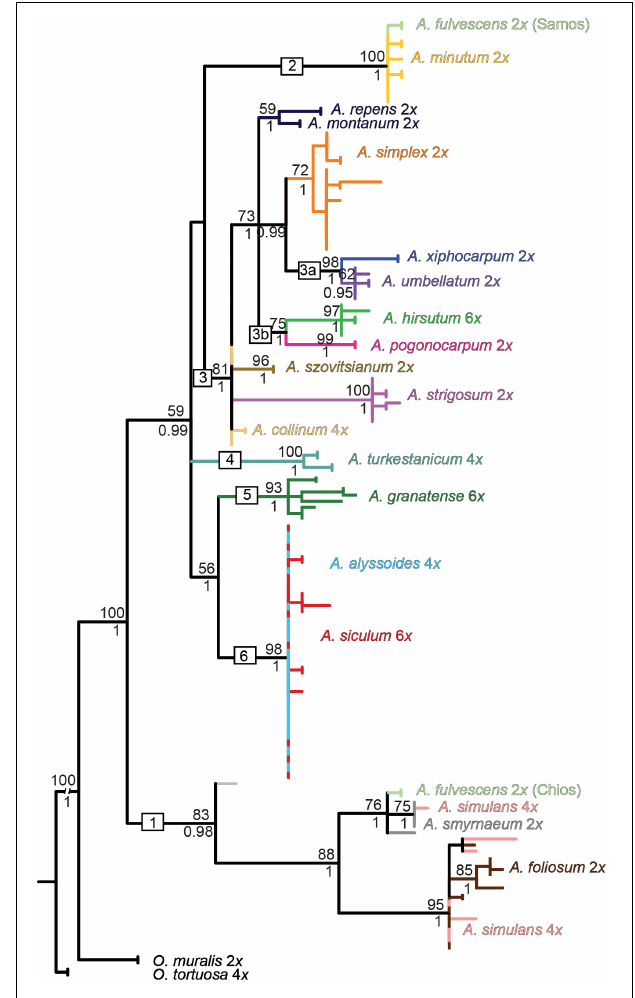
FIGURE 4 | Maximum-likelihood tree based on the rpoB-trnC sequences of cpDNA for the studied Alyssum species. The values above the branches are bootstrap support (BS) ≥ 50%; those below the branches are Bayesian posterior probability (BPP) values ≥ 0.75 taken from the Bayesian majority-rule consensus tree (not shown). BS and BPP are indicated only for major and species-specific clades, whereas they are skipped for the most terminal clades. Branches and clades are colored according to the species assignment, omitting the terminal labels of individual sequences for the sake of readability (see Supplementary Figure 1A for the fully labeled version of the tree). Each species name is followed by its ploidy level. The geographic origins of the two populations of diploid A. fulvescens that exhibited genetic divergence in each of the three DNA regions are indicated (Samos and Chios islands). The numbers 1-6 in boxes denote the clades, as described in the